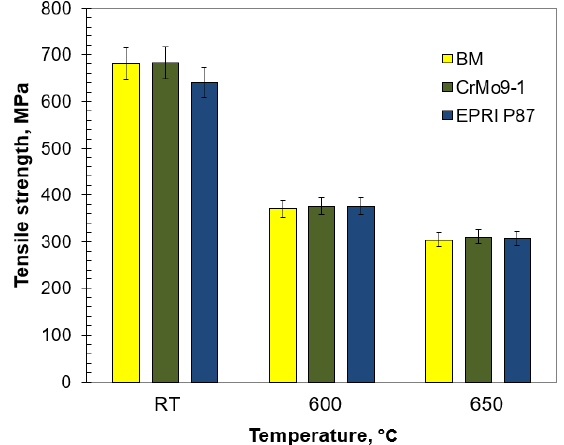
Figure 11. Hardness distribution profile across the cross-section of the joint welded with: ( a ) CrMo91, ( b ) EPRI P87.